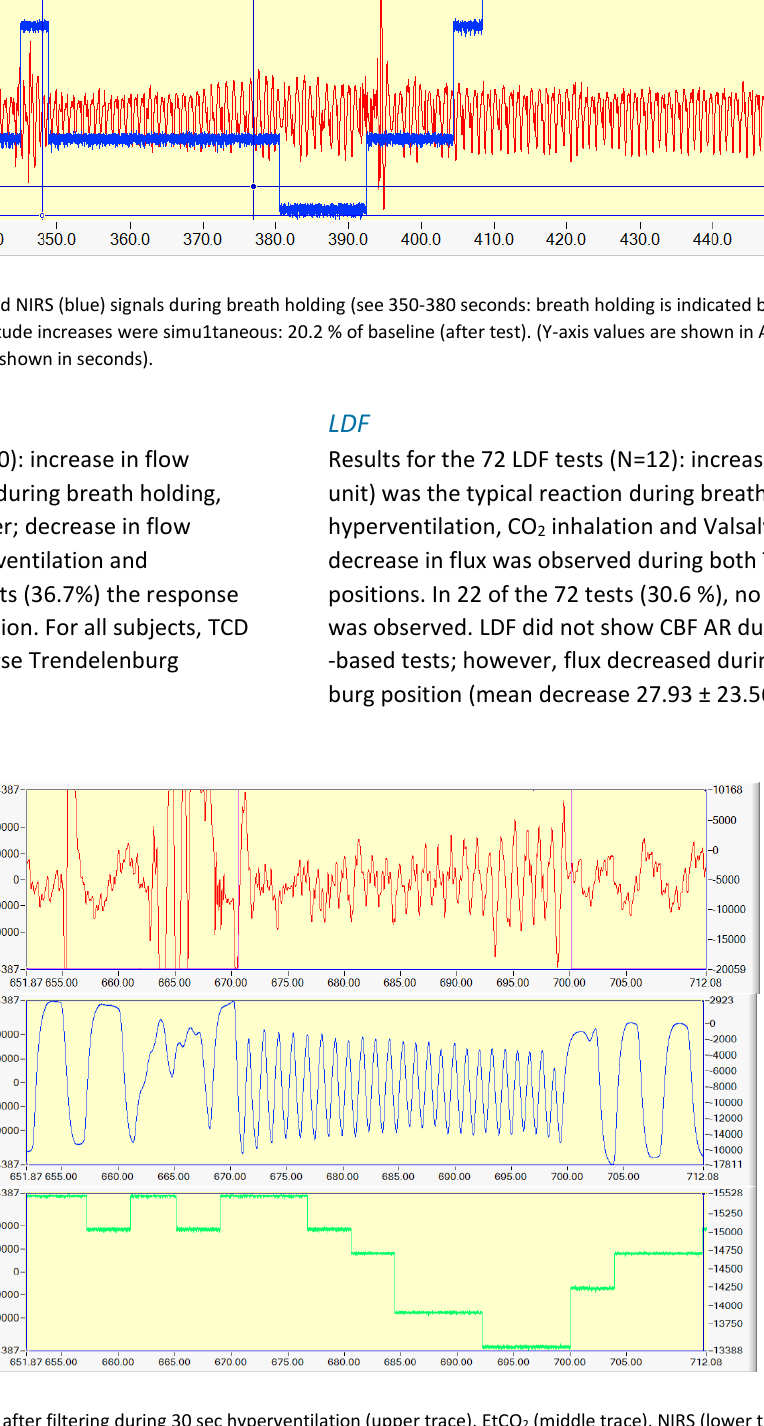
Fig. 3. Hyperventilation. REG signal after filtering during 30 sec hyperventilation (upper trace), EtCO 2 (middle trace), NIRS (lower trace). REG amplitude gradually increased during the test as NIRS synchronously decreased. (Y-axis values are shown in AD conversion units; X-axis values are shown in